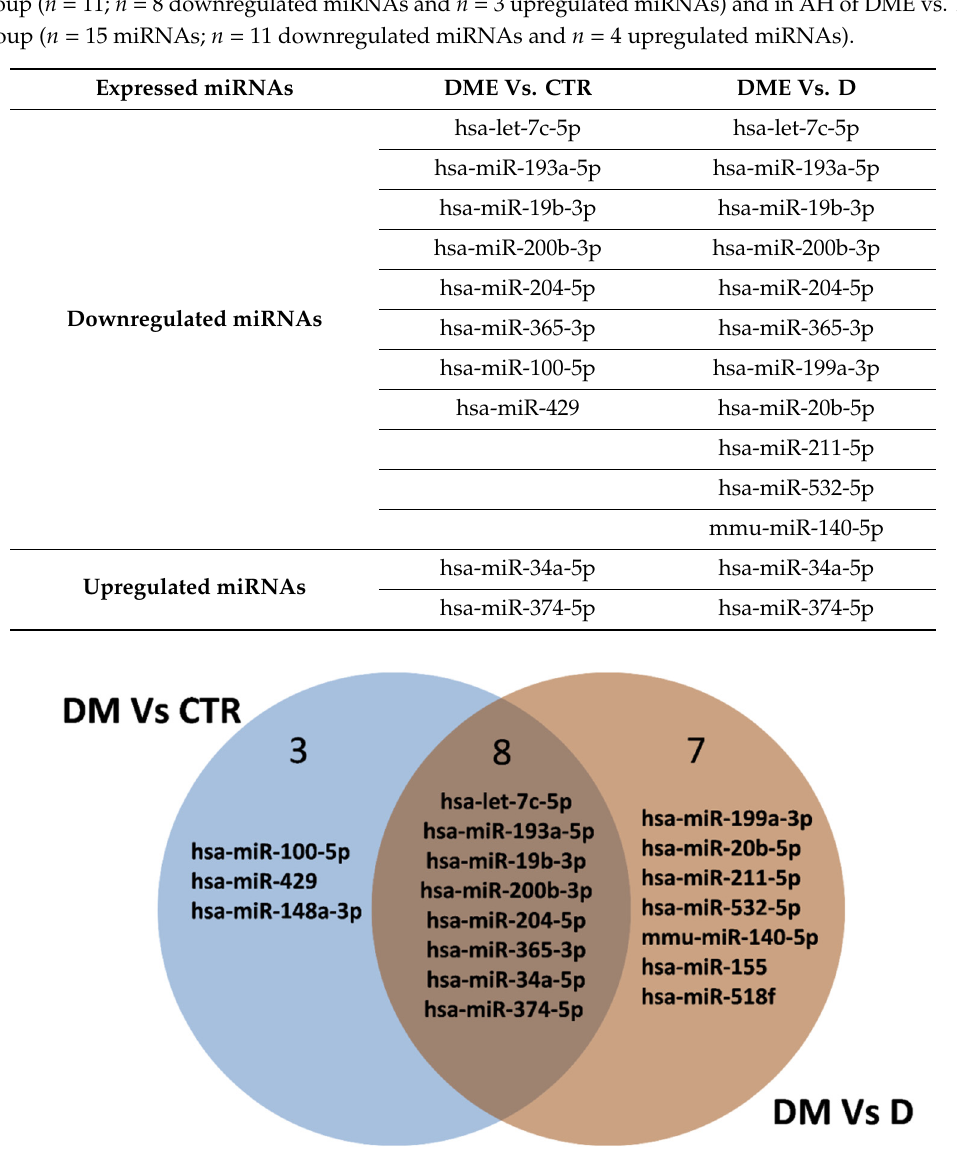
Figure 3. Venn diagram showing the differentially expressed miRNAs among the comparisons of DME vs CTR and of DME vs. D. Eight miRNAs resulted commonly differentially expressed among the comparisons of DME vs. CTR and of DME vs. D ( n = 6 downregulated miRNAs and n = 2 upregulated miRNAs).